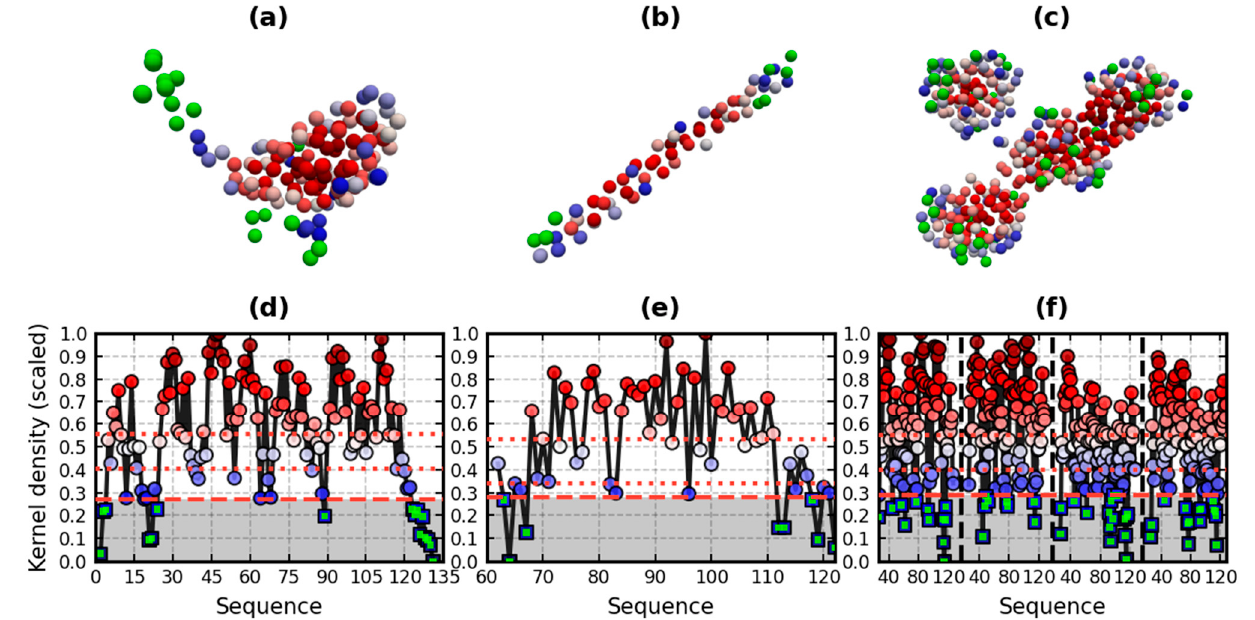
Figure 1. Effective atom density profiles for: monomer of dUTPase YncF (4B0H) ( a , d ), ATP Synthase B Chain (1L2P) ( b , e ) and four monomers of DnaB Helicase (1B79) ( c , f ). Shaded regions on ( d – f ) mark residues with kernel density below threshold t (green squares under the red dashed line), calculated using three medians of the profile ( m = 3). Their effective atoms—assumed to be structural outliers—are shown on ( a – c ) as green spheres. Guide effective atoms—non-green spheres on ( a – c )—are colored in accordance with their kernel density values from ( d – f ). Thresholds matching first ( m = 1) and second ( m = 2) medians are symbolized by red dotted lines. Vertical dashed lines on ( f ) denote chain boundaries.